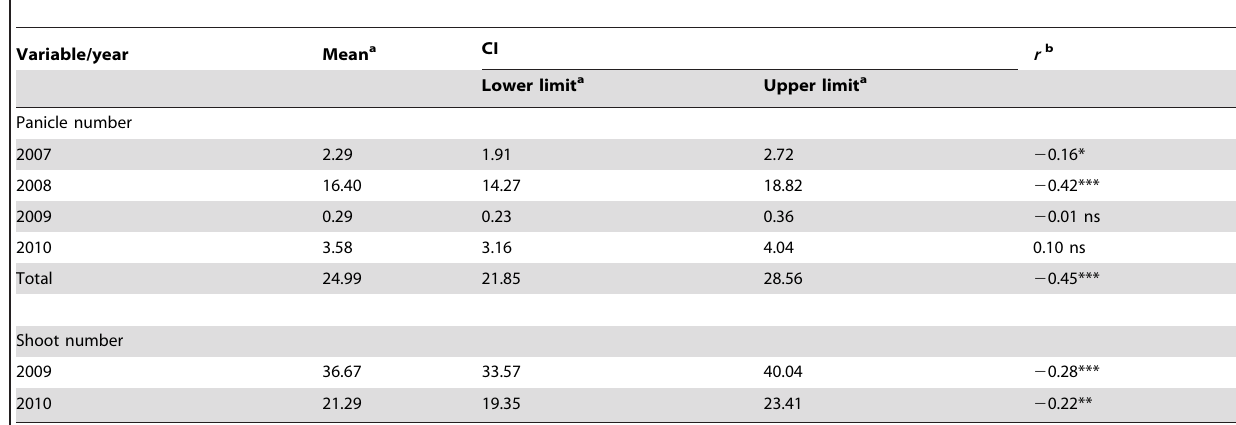
Table 1. Means, 95 percent confidence intervals (CI) and within-pair correlations ( r ) for traits measured on S. album plants used in the present experiment.